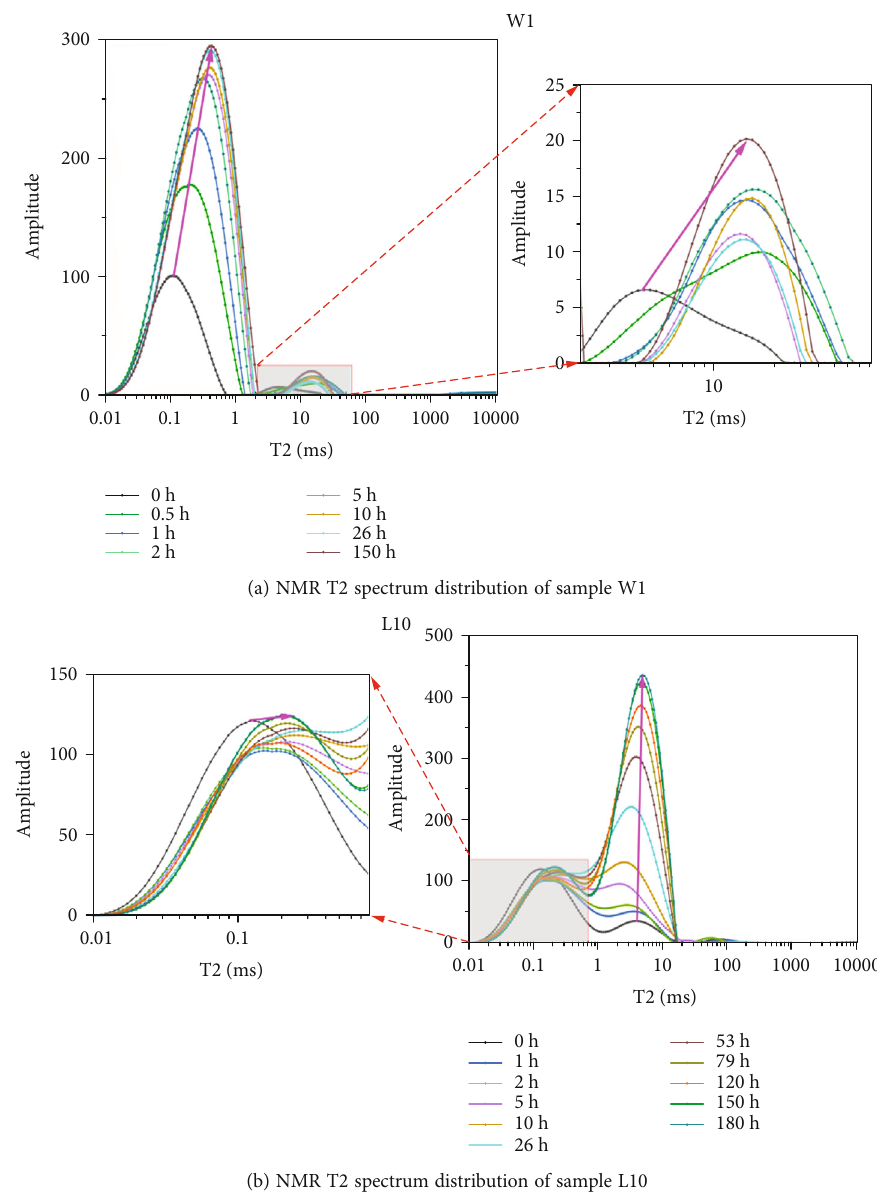
Figure 8: NMR T2 spectrum distribution of the deep shale during spontaneous